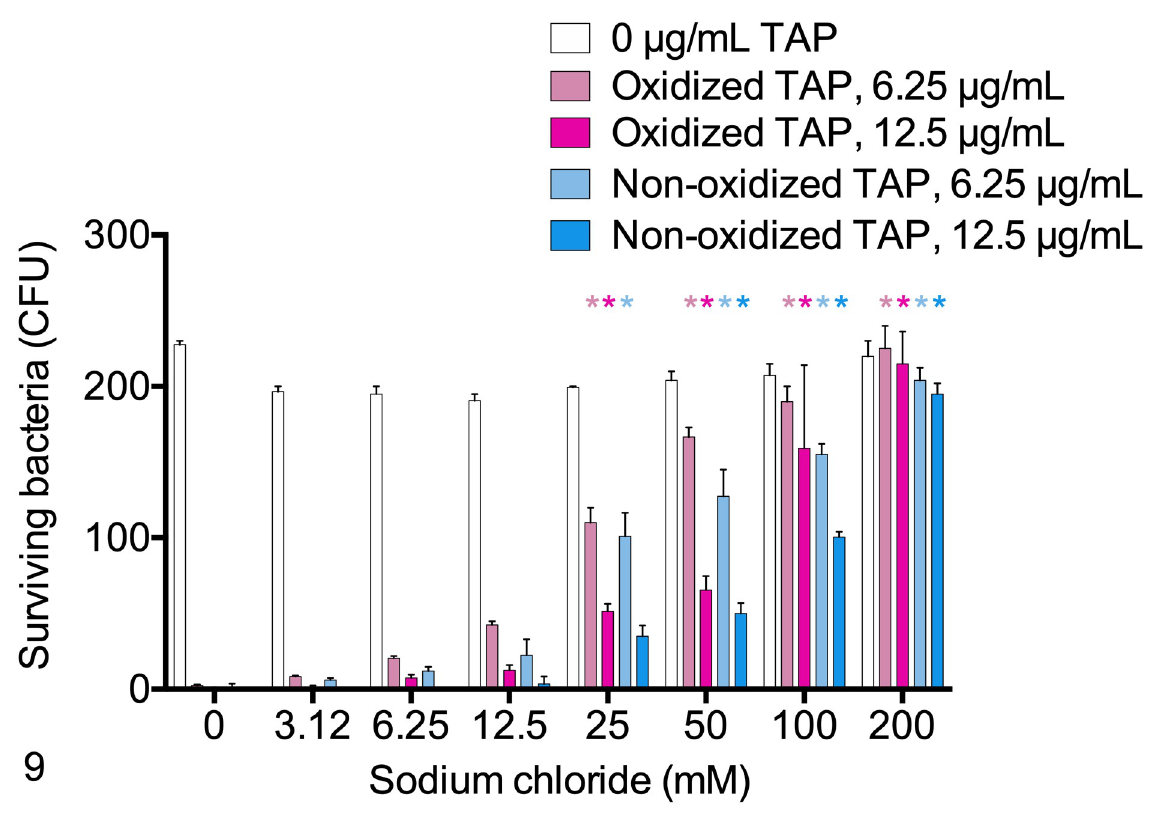
Fig 9. Effects of sodium chloride on survival of Mannheimia haemolytica B158 in the presence of oxidized or non-oxidized tracheal antimicrobial peptide (TAP). Different concentrations of sodium chloride were mixed with 2 different concentrations of oxidized or non- oxidized TAP or buffer before incubating with M . haemolytica for 1 hour. The mixtures were inoculated onto blood agar plates, and colonies (surviving bacteria) were counted the next day. � P < 0.05 compared to no sodium chloride, 2-way ANOVA, n = 3 replicates per group. CFU, colony-forming